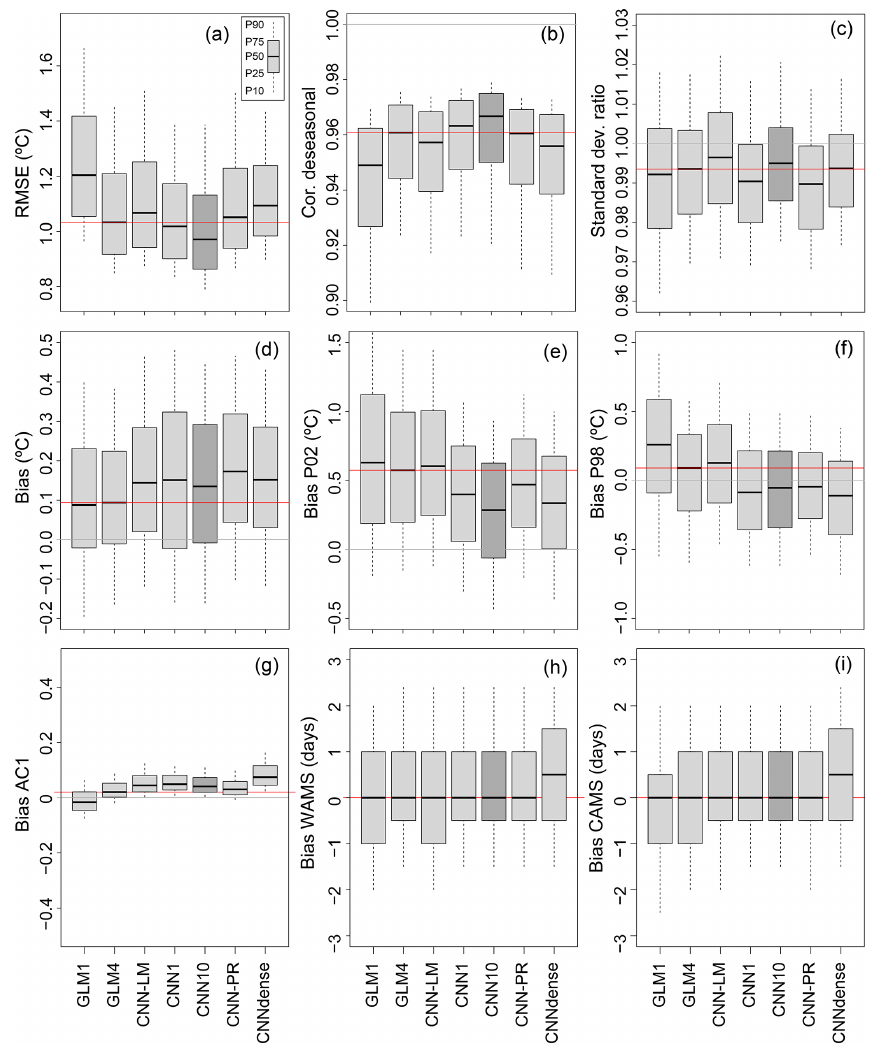
Figure 4. Validation results obtained for temperature. Each panel (corresponding to a particular metric) contains seven boxplots, one for each of the methods tested, which represents the spread of the results along the entire E-OBS grid (the gray boxes correspond to the 25– 75th-percentile range, whereas the whiskers cover the 10–90% range). The horizontal red line plots the median value obtained from the GLM4 method, which is considered as a benchmark, whereas the gray one indicates the “perfect” value for each metric. The dark shaded box indicates the best-performing method, taking into account all metrics simultaneously (CNN10 in this